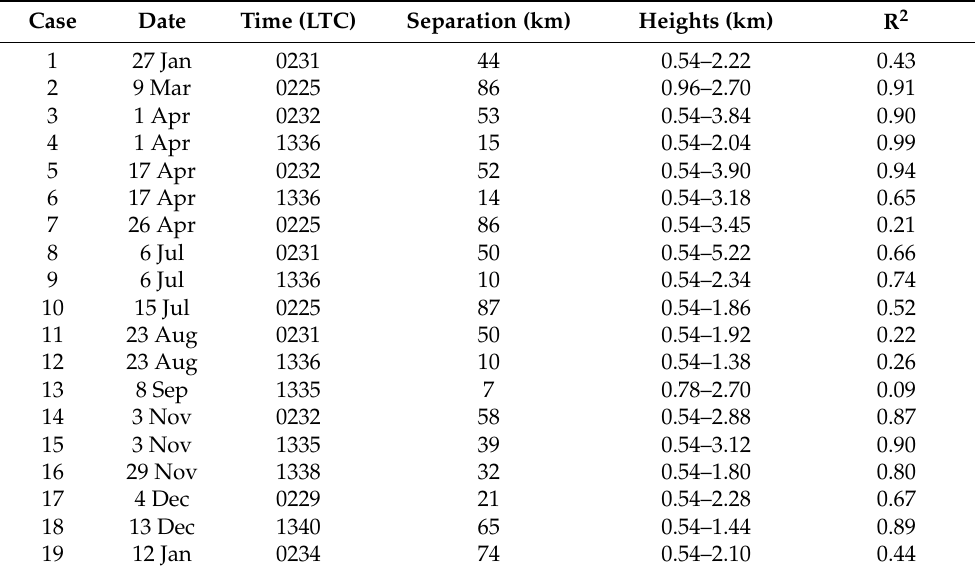
Table 1. Cloud–aerosol lidar and infrared pathfinder satellite observations (CALIPSO) overpasses used for comparison during our observation